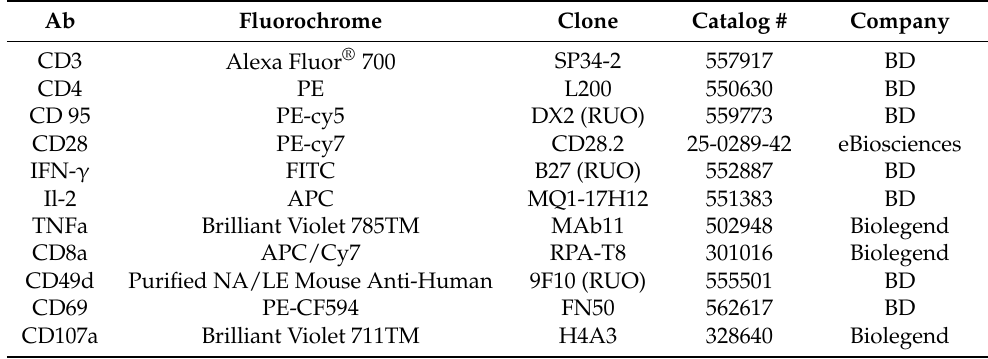
Table 1. Antibodies used for T-cell intracellular